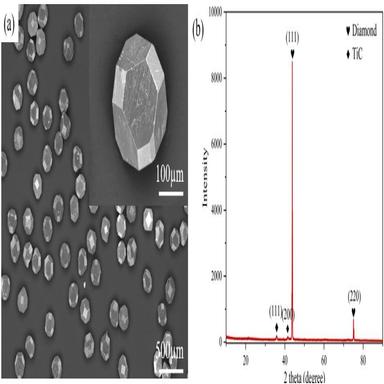
Characteristics of Ti-coated diamond particles: (a) morphology, and (b) XRD patterns for phase analysis.